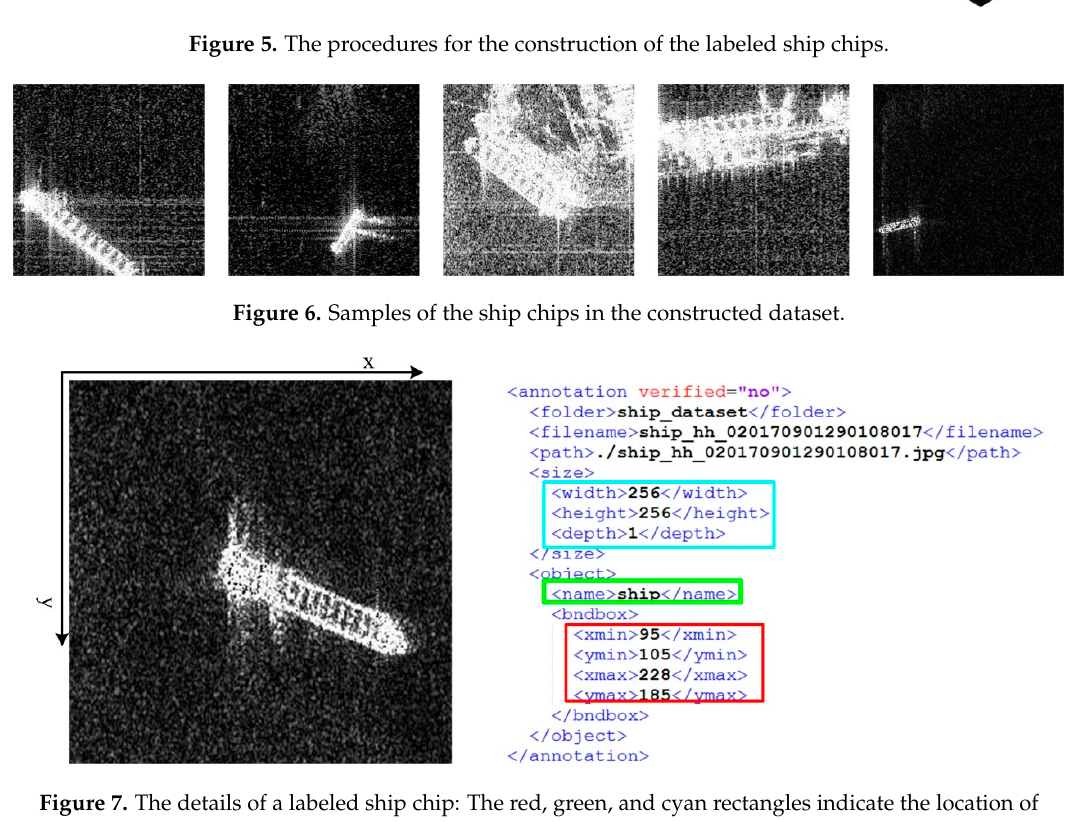
Table 2. Six configurations of RetinaNet and their corresponding ship detection mean average precision (mAP).